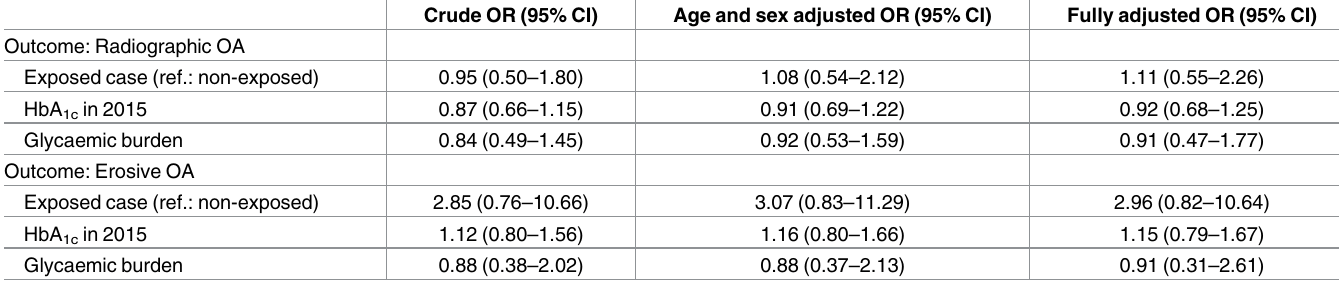
Table 2. Associations between case-control status, HbA 1c , glycaemic burden and structural hand OA